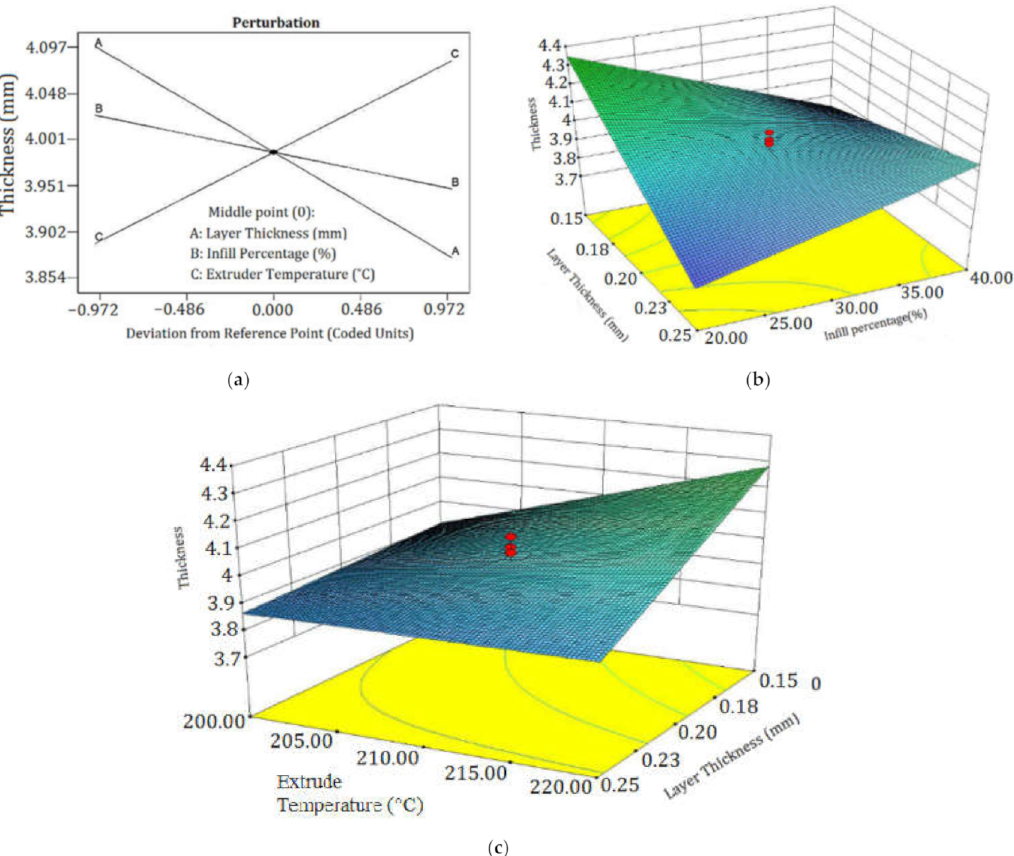
Figure 10. ( a ) Perturbation plot of thickness, ( b ) 3D-SP of thickness in phrases of LT and IP, and ( c ) 3D-SP of thickness in phrases of ET and LT.